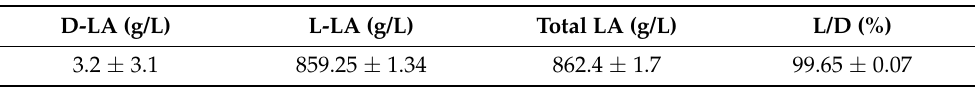
Table 2. The amount of the different lactic acid isomers obtained at the end of the downstream process after the evaporation process in both pilot scale fermenters using carob bagasse. Each value is the mean ± SD of two